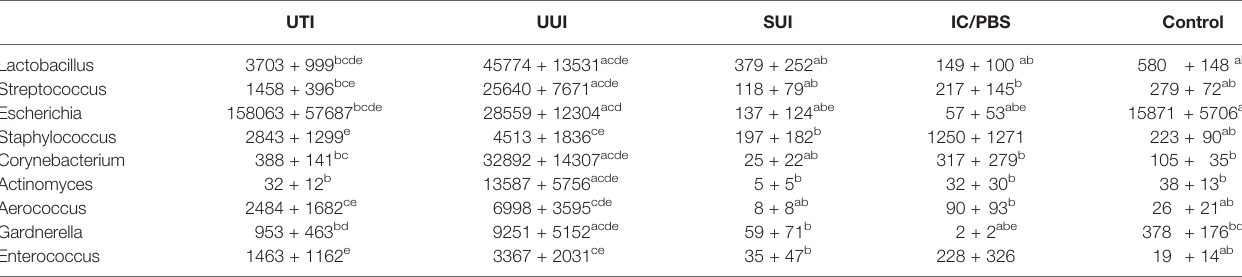
TABLE 4 | Age adjusted mean (CFU/mL) ± standard